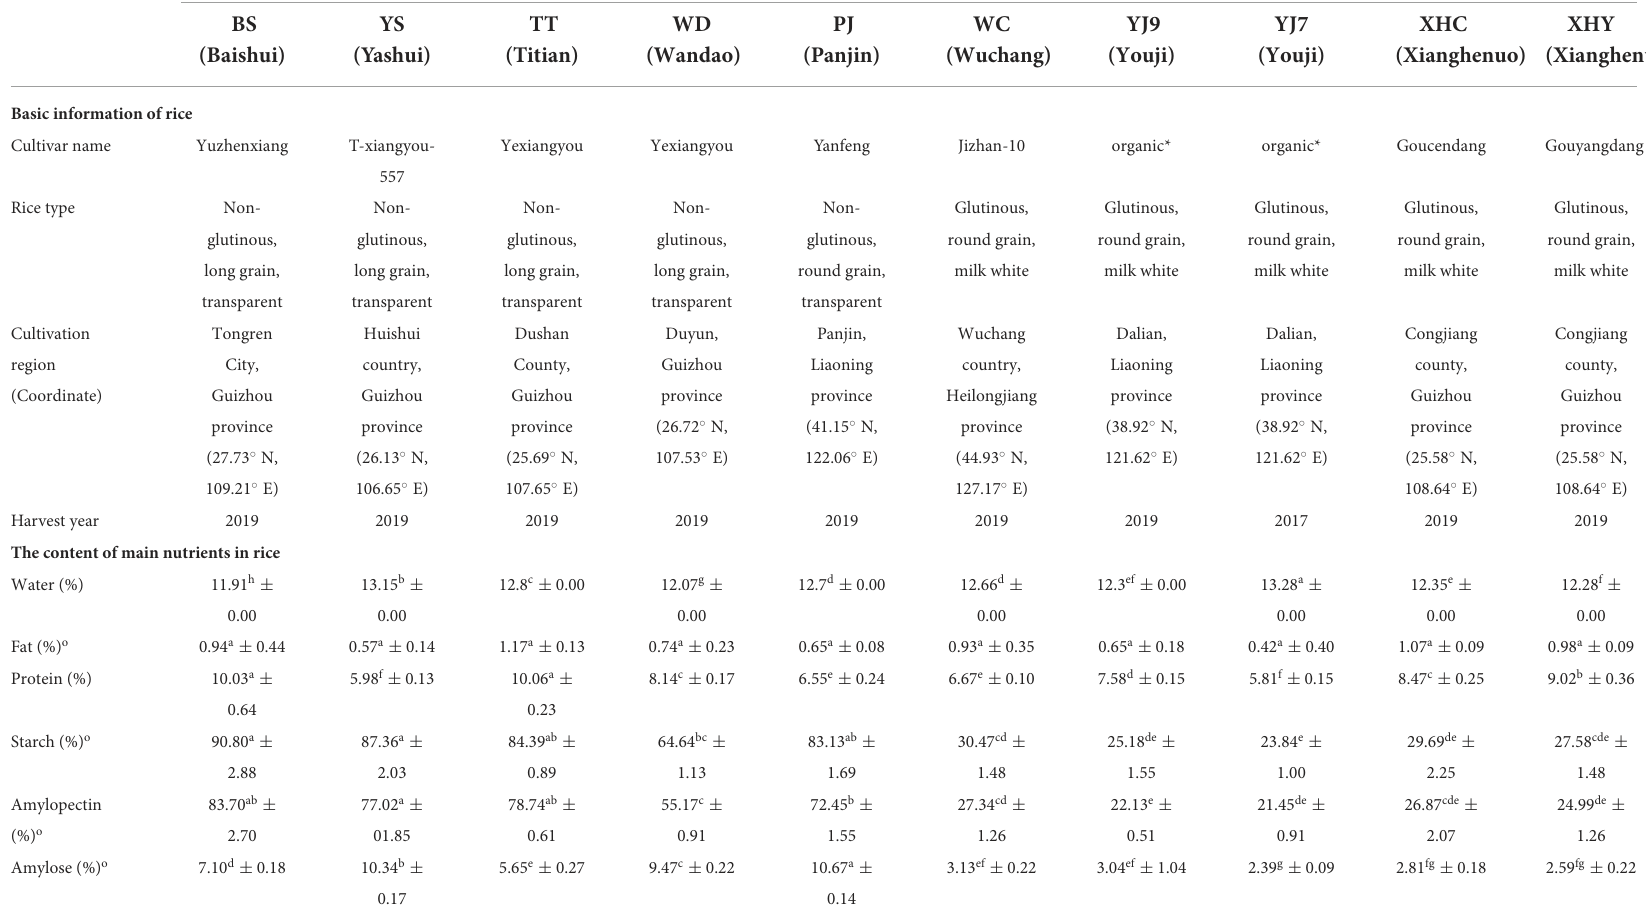
TABLE 1 The content of main nutrients in rice and the content of higher alcohols in rice wine.